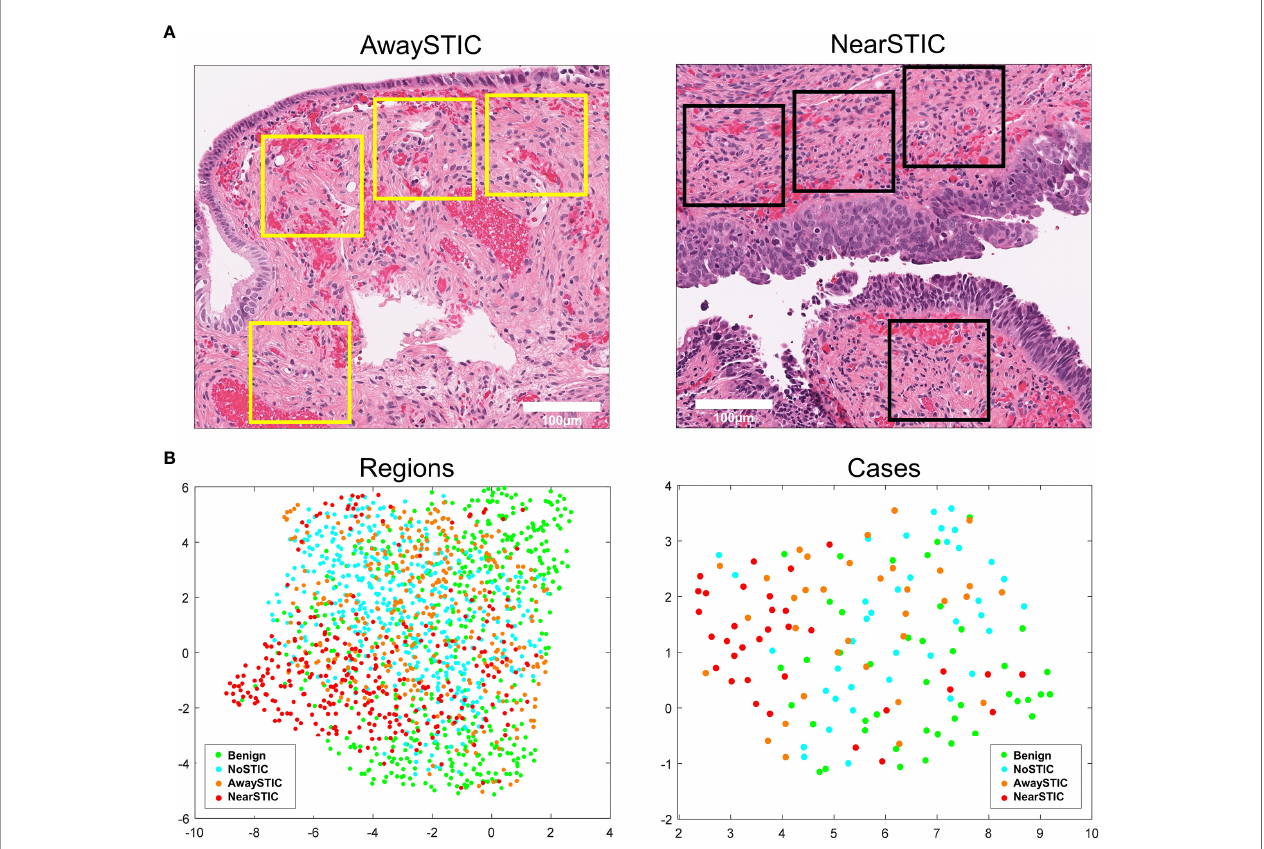
FIGURE 1 | The fallopian tube stromal architecture changes both locally and globally in the presence of STIC lesions. (A) Yellow boxes illustrate stromal regions where tiles were extracted away from the STIC lesion (left panel) and black boxes illustrate stromal regions where tiles were extracted near the STIC lesion (right panel). (B) Low-dimensional UMAP representation of stromal morphometric features in regions and cases with benign fallopian tubes (Benign), uninvolved fallopian tubes from patients with HGSOC (NoSTIC), and fallopian tubes with STIC lesions and HGSOC. Image regions from fallopian tubes with STIC lesions were strati fi ed based on proximity to the lesion (awaySTIC and nearSTIC). Expression in an individual case represents median expressions from regions in that case. The UMAP plots were generated using the run_umap.m function in